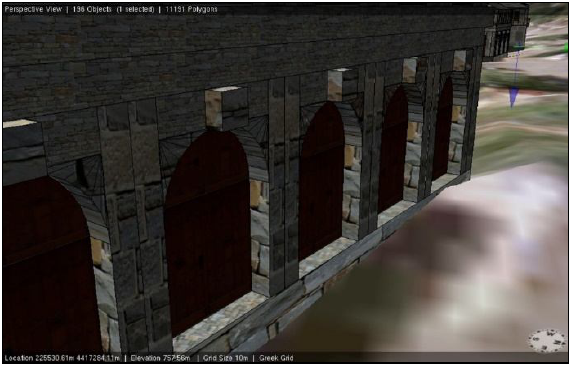
Figure 10. Detail of generated arc